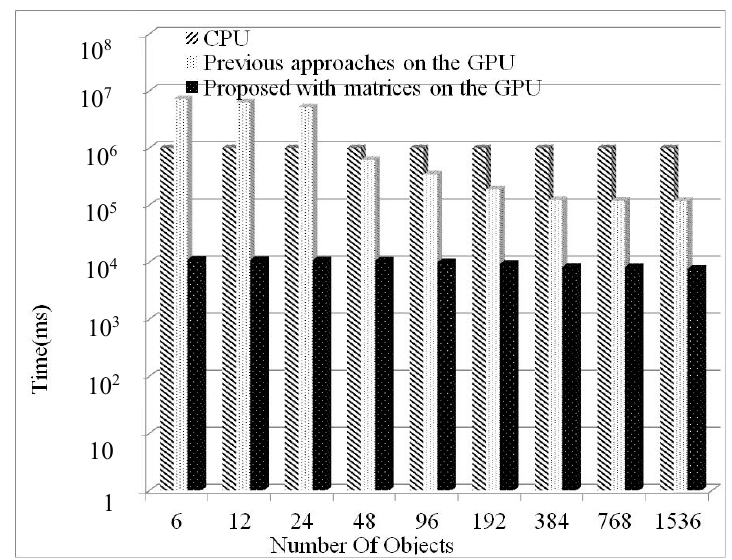
Figure 8. Comparison of previous and new methods for GPU optimization of active membrane systems. Execution times are associated with previous methods (Figure 3) and the algorithm presented in this paper (Figure 7).